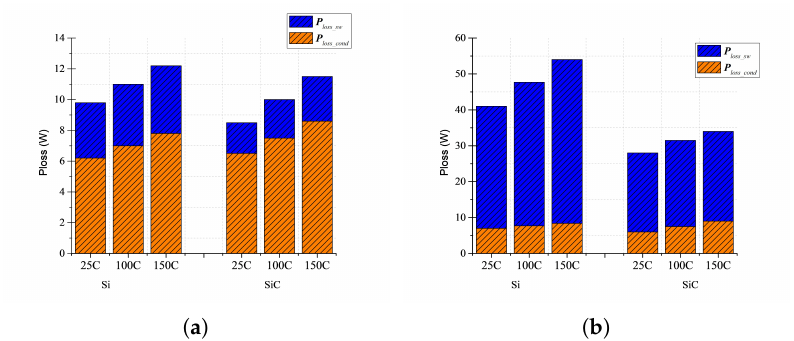
Figure 20. Switching and conduction losses at ( a ) F sw = 10 kHz and ( b ) F sw = 100